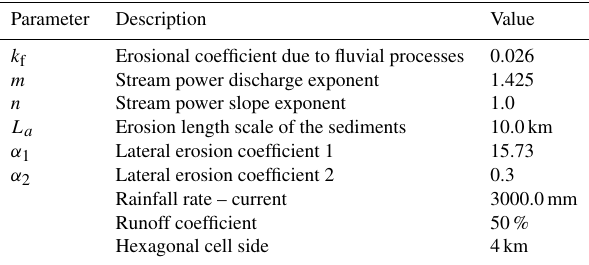
Table 1. Fixed parameters in all simulated scenarios.